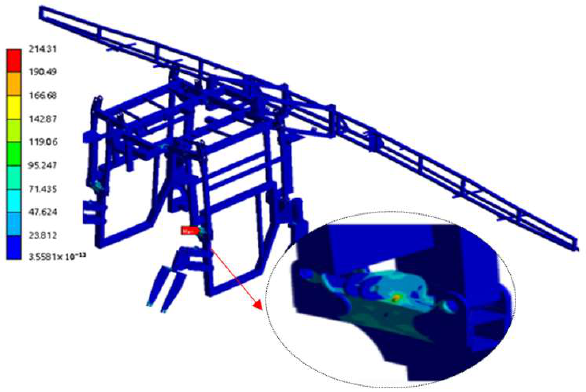
Figure 8. Von Mises stresses diagram of the frame with full load bending condition.